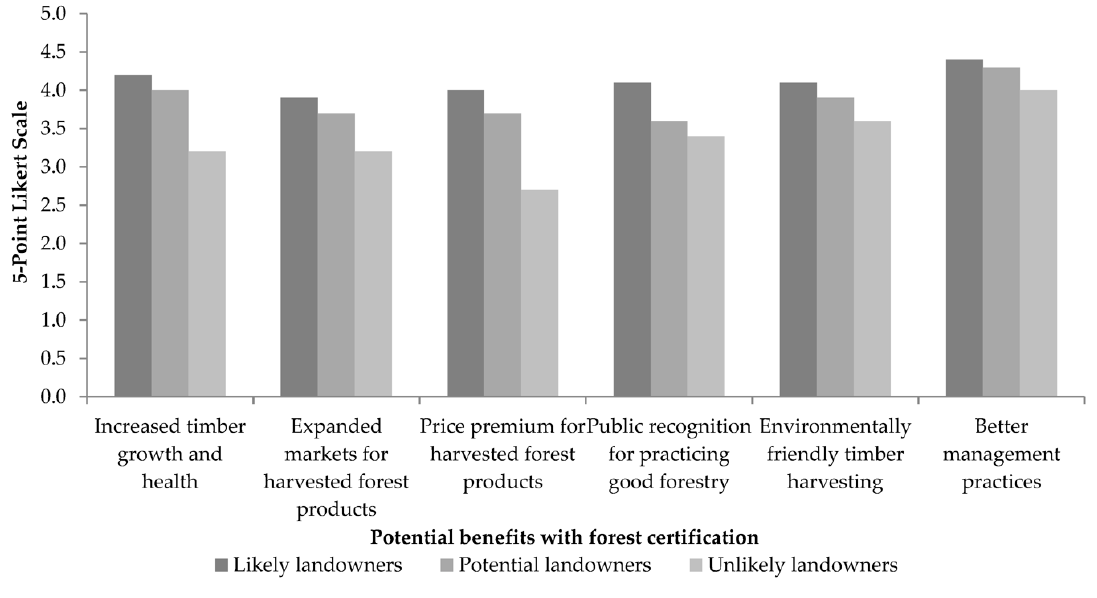
Figure 2. Landowners’ perception of potential benefits of forest certification.